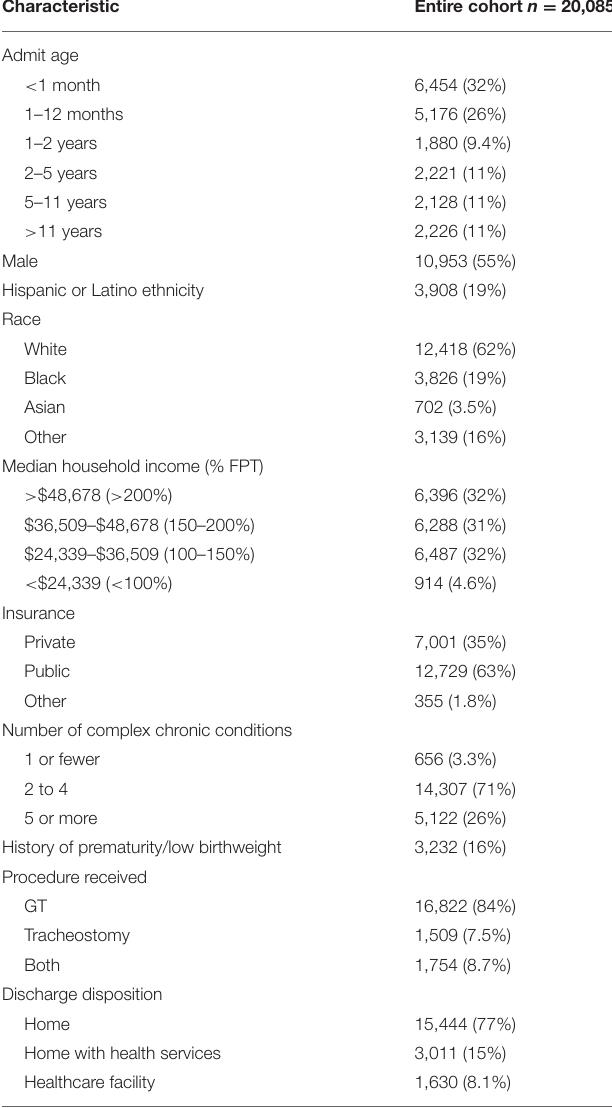
TABLE 1 | Patient demographics and clinical characteristics at index admission in a cohort of technology-dependent children.